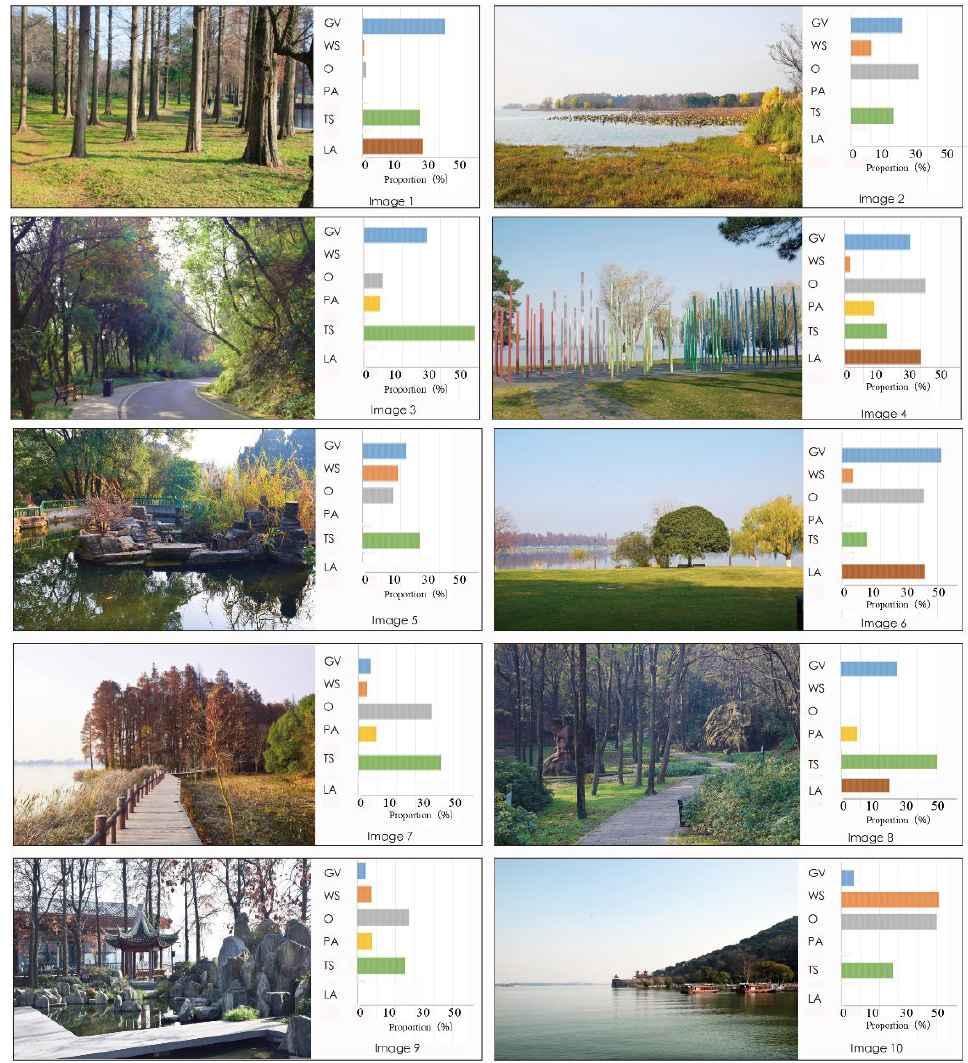
Figure 4. The physical characteristic of the sample photos. GV = Green Visibility; WS = Water Space; O = Openness; PA = Pavement Area; TS = Tree and Shrub area; LA = Lawn Area; C = Colorfulness; PR = Plant Richness.